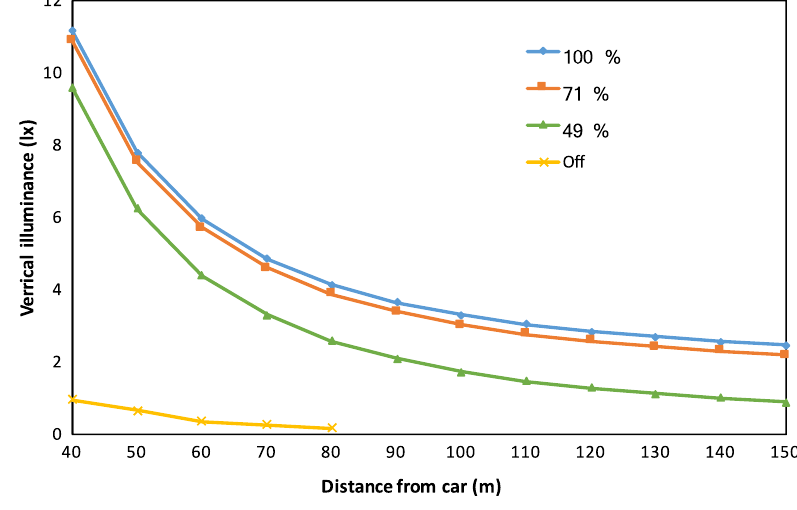
Fig.4 Verticalilluminance (lx)at different distances from